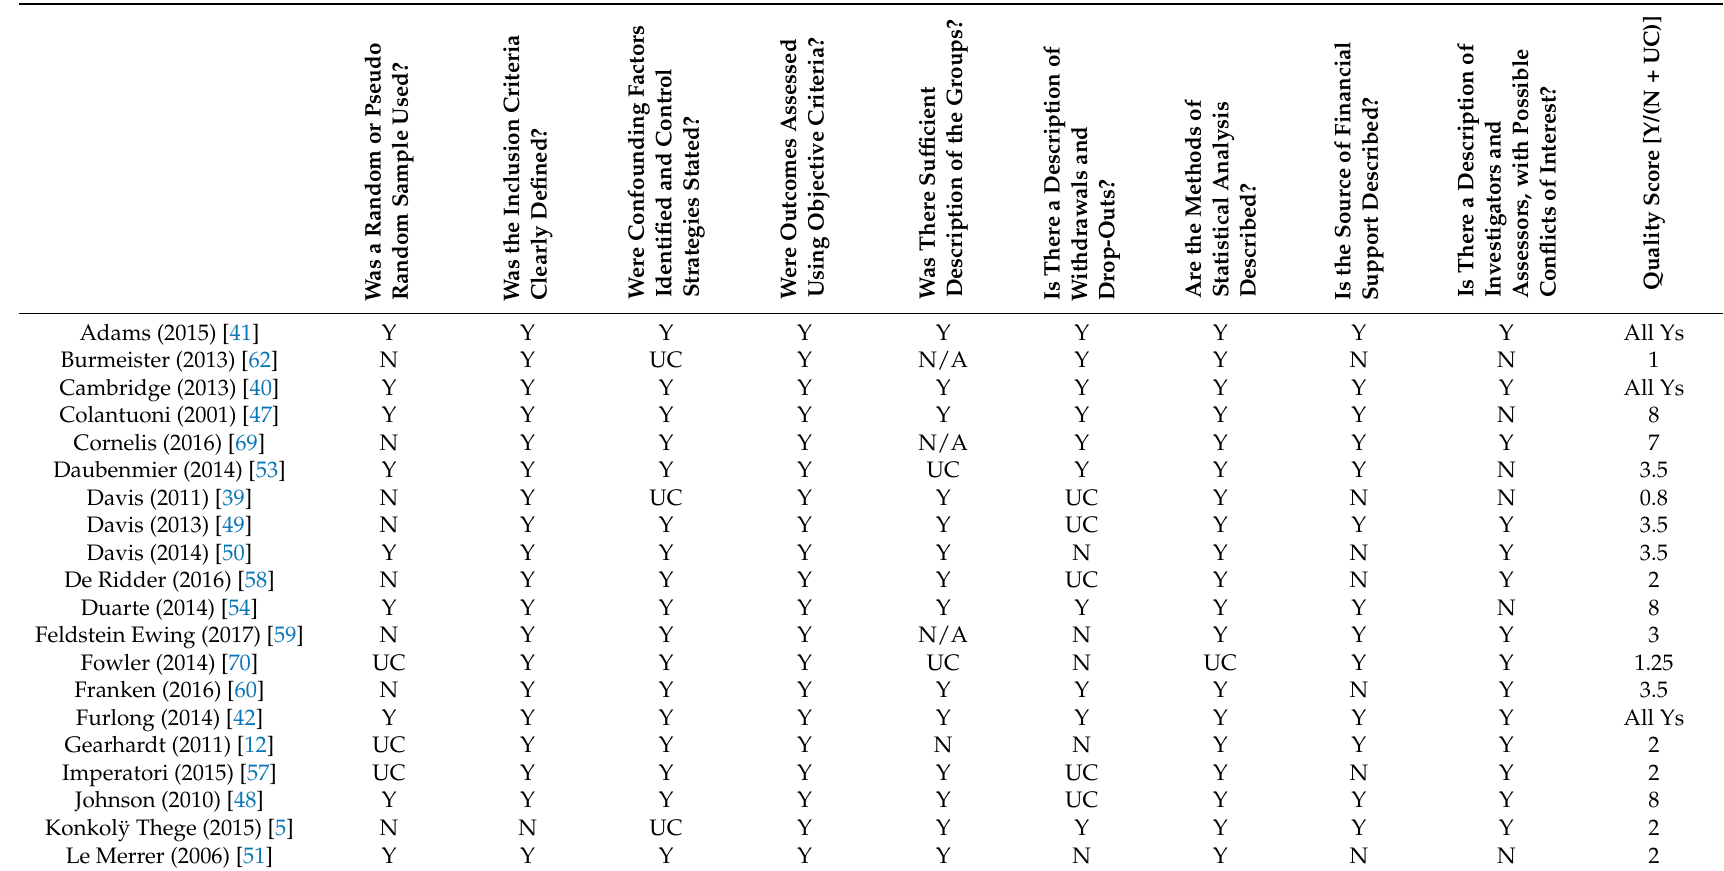
Table A2. Risk of bias assessment of included